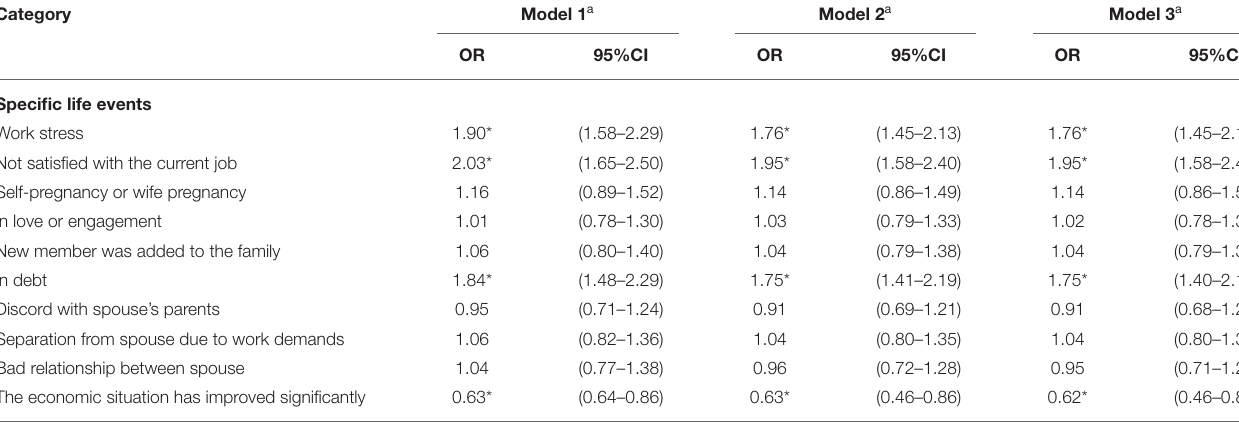
TABLE 5 | Longitudinal associations between specific life events at baseline and self-reported fatigue at